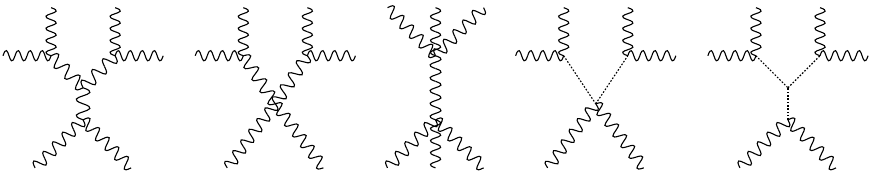
Figure 1 . Feynman diagrams contributing to scattering processes involving six electroweak gauge